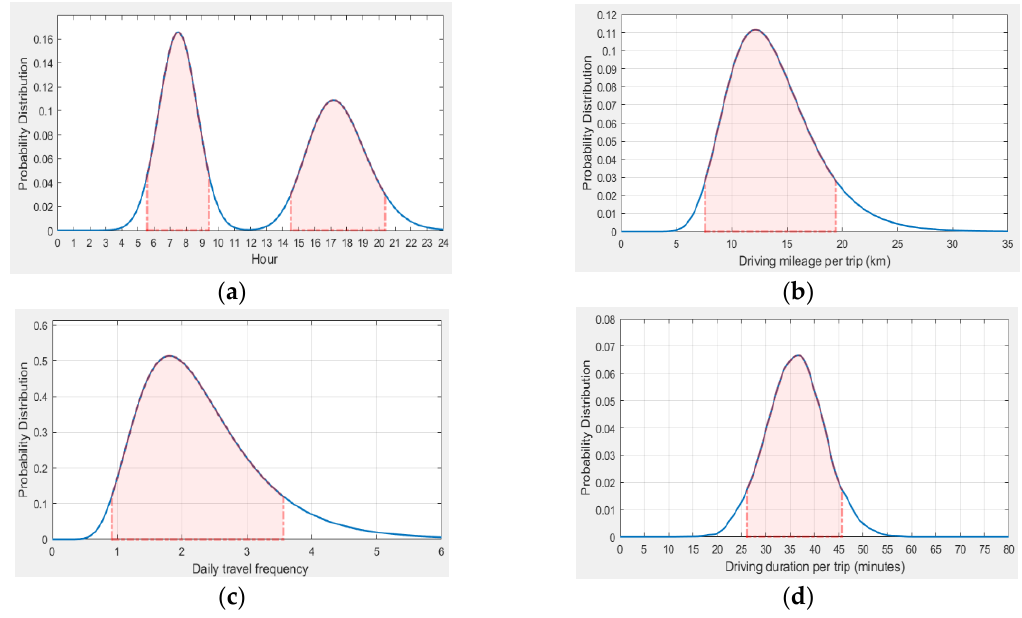
Figure 1. Travel behaviour: ( a ) daily starting trip time; ( b ) kilometres travelled per day; ( c ) number of trips per day; ( d ) trip duration.